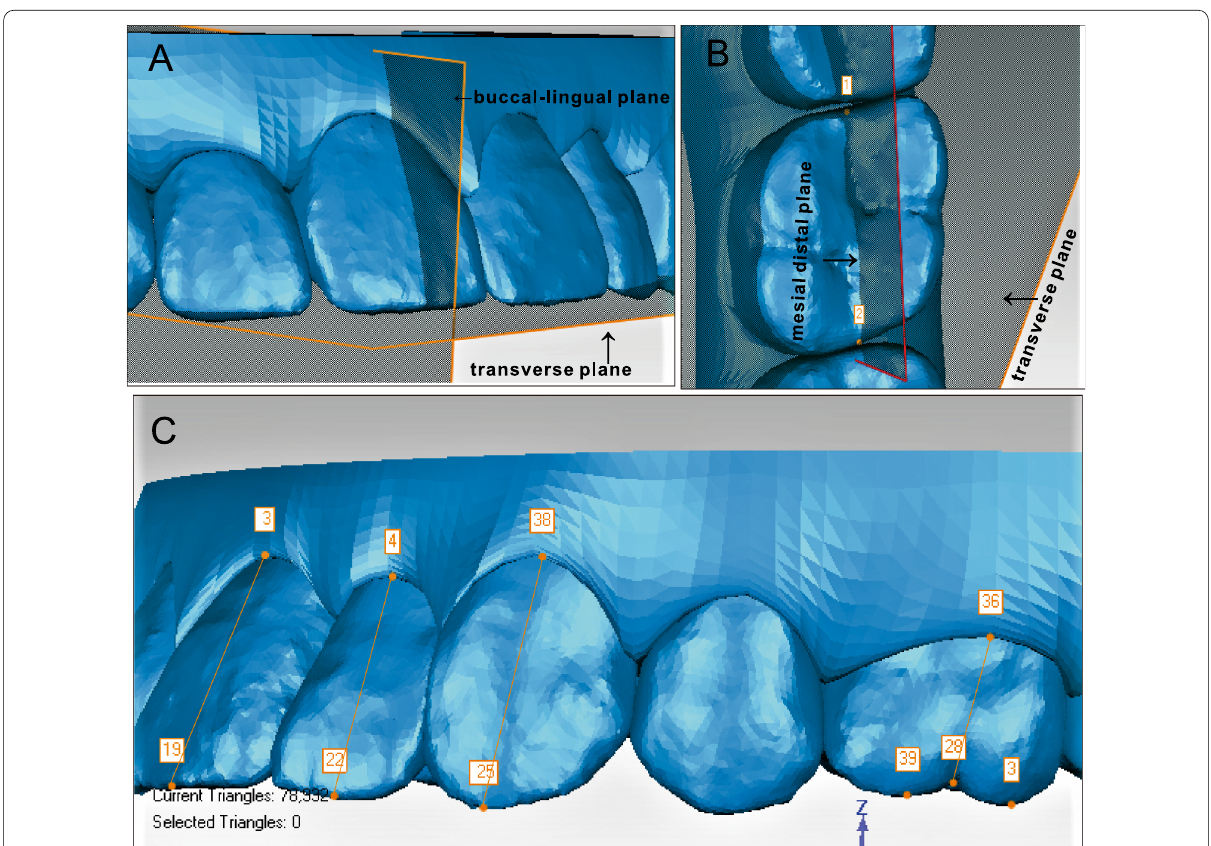
Fig. 2 Point digitization and establishment of local tooth plane to measure angles. A Establishment of buccal lingual plane of the central incisor. B Establishment of mesial–distal plane of the first molar. C Point digitization of central incisors, canines and first molars, and axis of central incisors, canines, and first